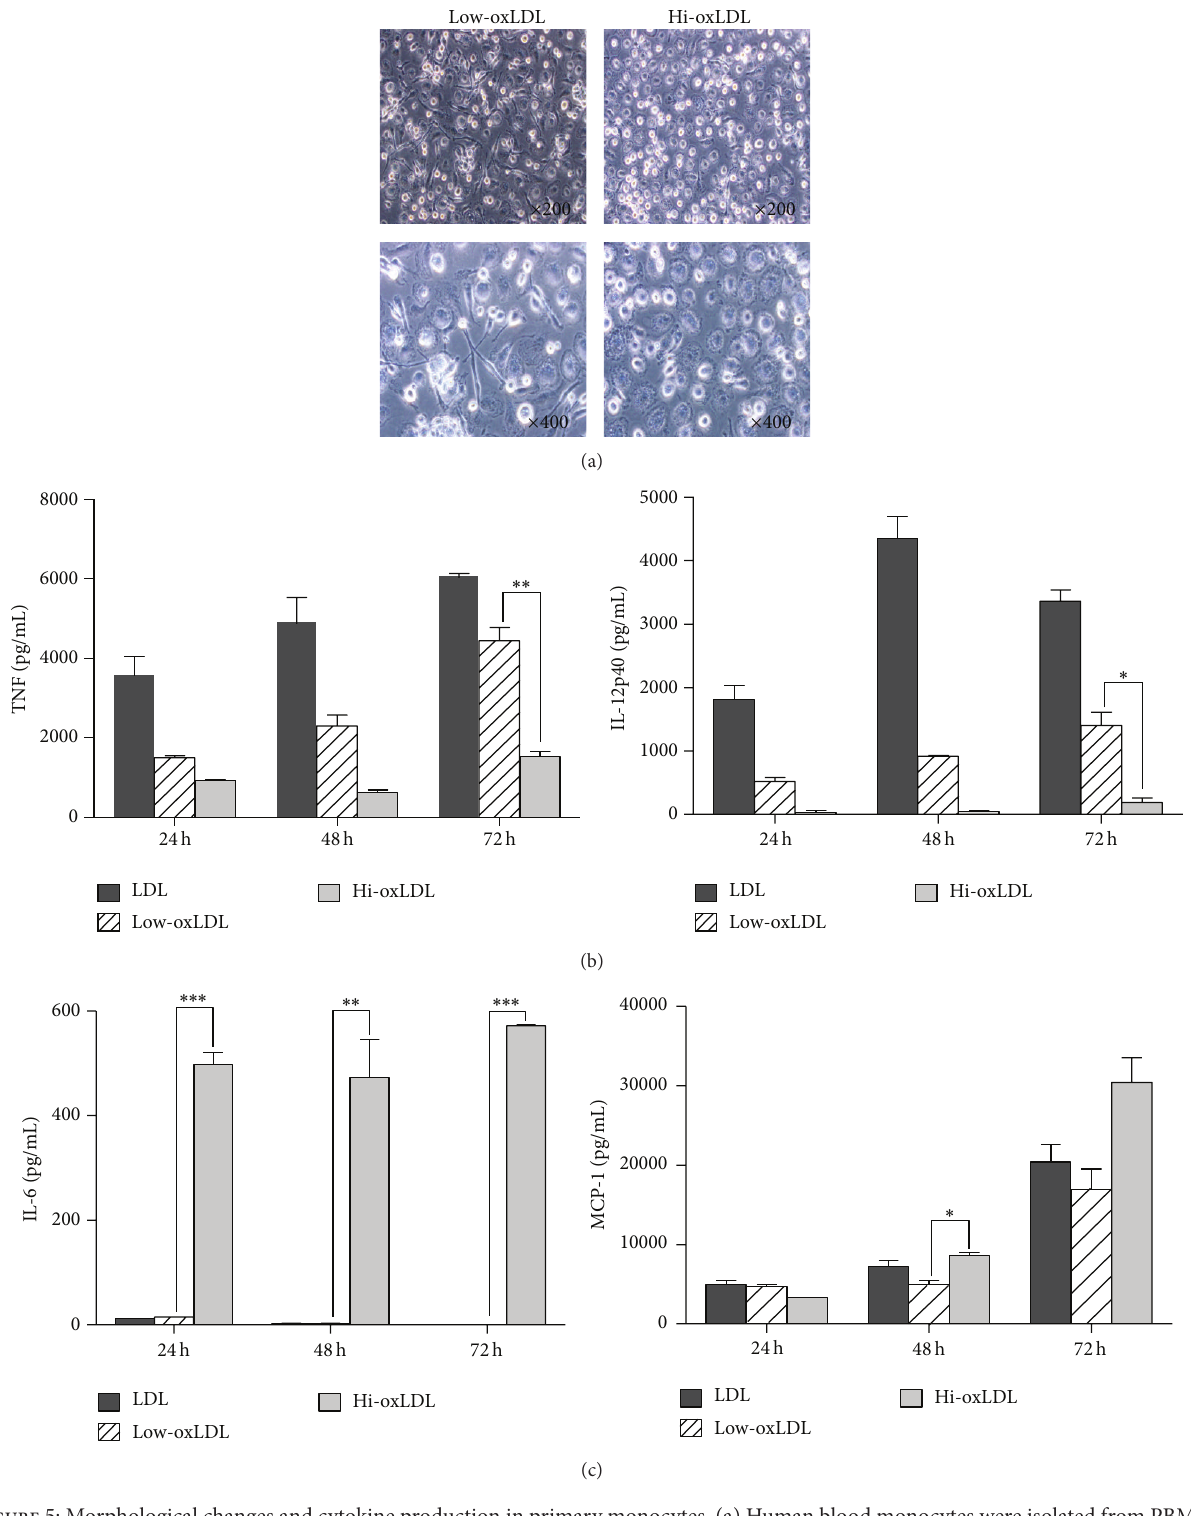
Figure 5: Morphological changes and cytokine production in primary monocytes. (a) Human blood monocytes were isolated from PBMCs and cultured with both M-CSF (50ng/mL) and differentially oxidized LDL (50 𝜇 g/mL each) for 7 days. Morphological changes were observed using bright-field microscope ( × 200, 400). (b) Primary monocytes were pretreated with both M-CSF (50 ng/mL) and differentially oxidized LDL (50 𝜇 g/mL) for 24, 48, or 72 h and treated with LPS (20ng/mL) for 18h. Culture supernatants were harvested and the levels of TNF- 𝛼 , IL-12p40, IL-6, and MCP-1 were measured by ELISA. Data represent means ± S.E. and one-way ANOVA analysis was used to determine significance ( ∗ 𝑝 < 0.05 , ∗∗ 𝑝 < 0.01 , and ∗∗∗ 𝑝 < 0.001